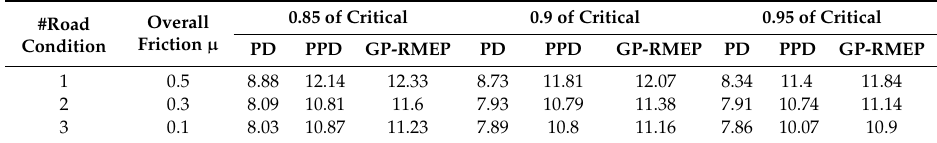
Figure 11. Car trajectory on the track tuned with prediction SAF of standard PD controller for friction coefficient µ = 0.1 with target speed equal to 1.05(cid:1848) (cid:3004)(cid:3019) . The blue curve corresponds to the trajectory controlled by PPD controller, and red to the original PD controller.